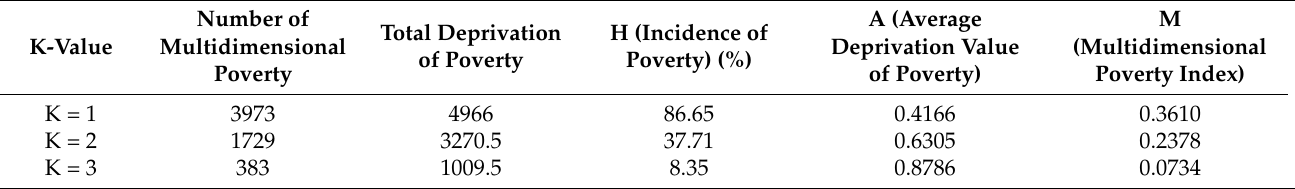
Table 2. Multidimensional relative poverty index of the rural elderly.